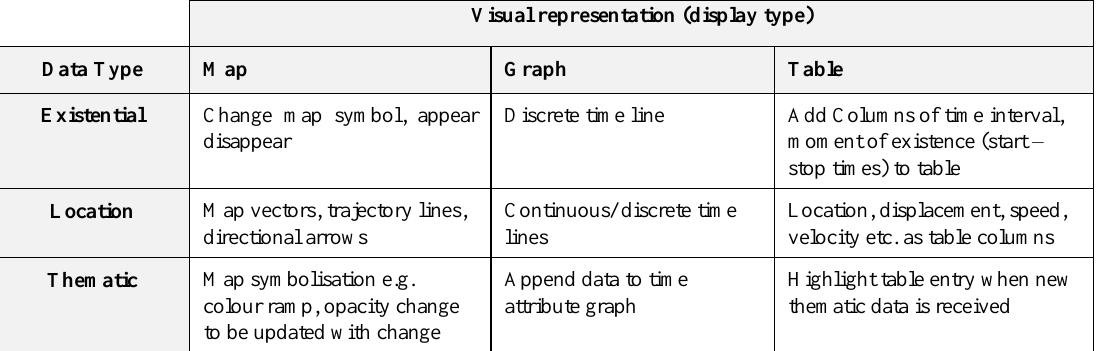
Visual representation (display type)